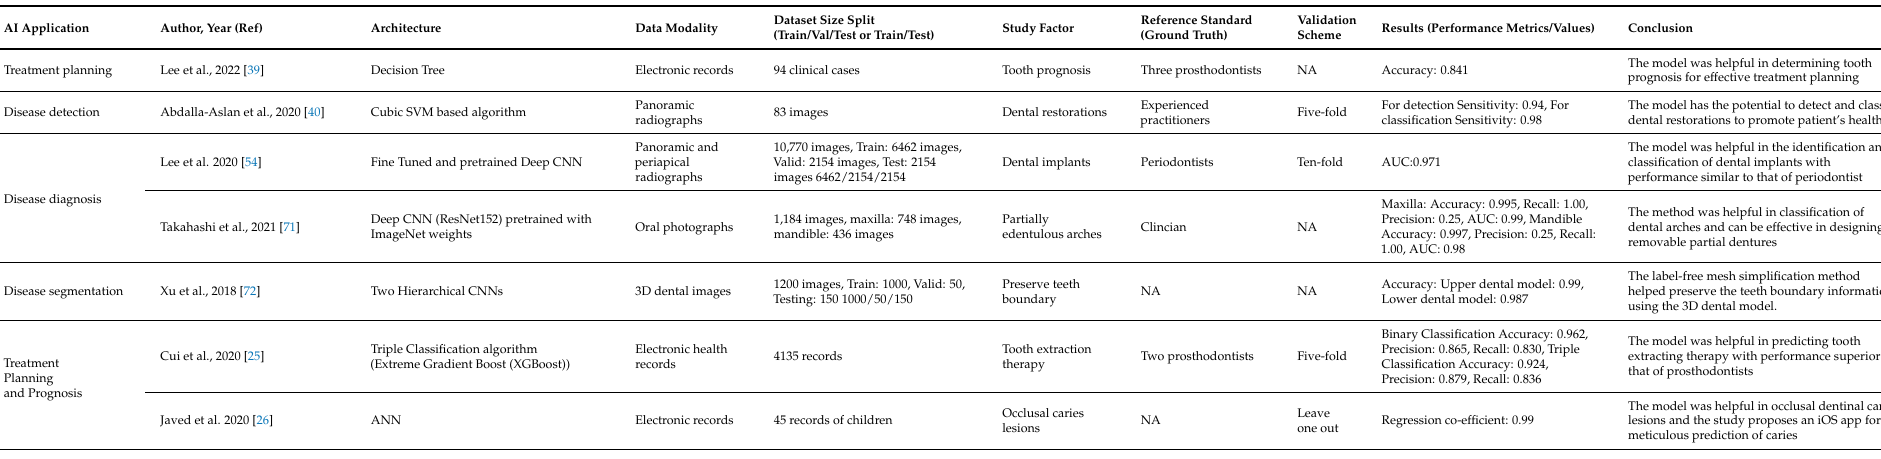
Table 6. Summary of related studies for AI application in prosthetic/restorative dentistry.